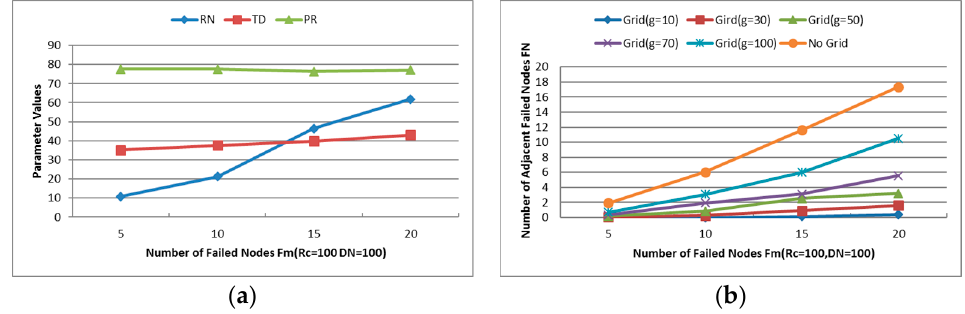
Figure 14. ( a ) Parameter values with different Fm; and ( b ) FN with different Fm.